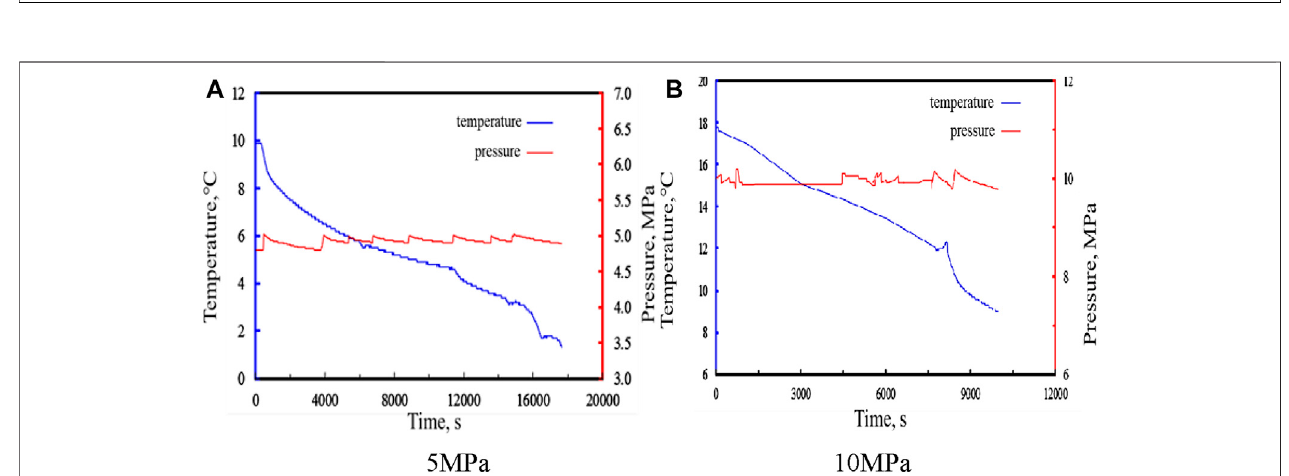
FIGURE 7 | Variation of temperature and pressure at 3% inhibitor concentration. ( A :5 MPa; B :10 MPa).